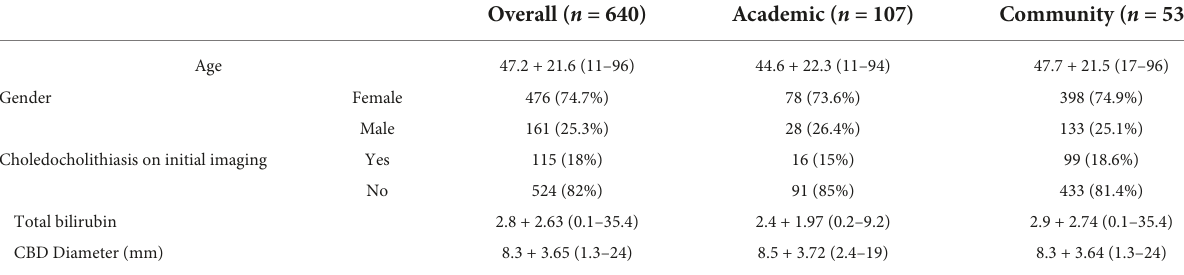
TABLE 1 Demographics and clinical characteristics comparing subjects in the academic vs. community practice groups.